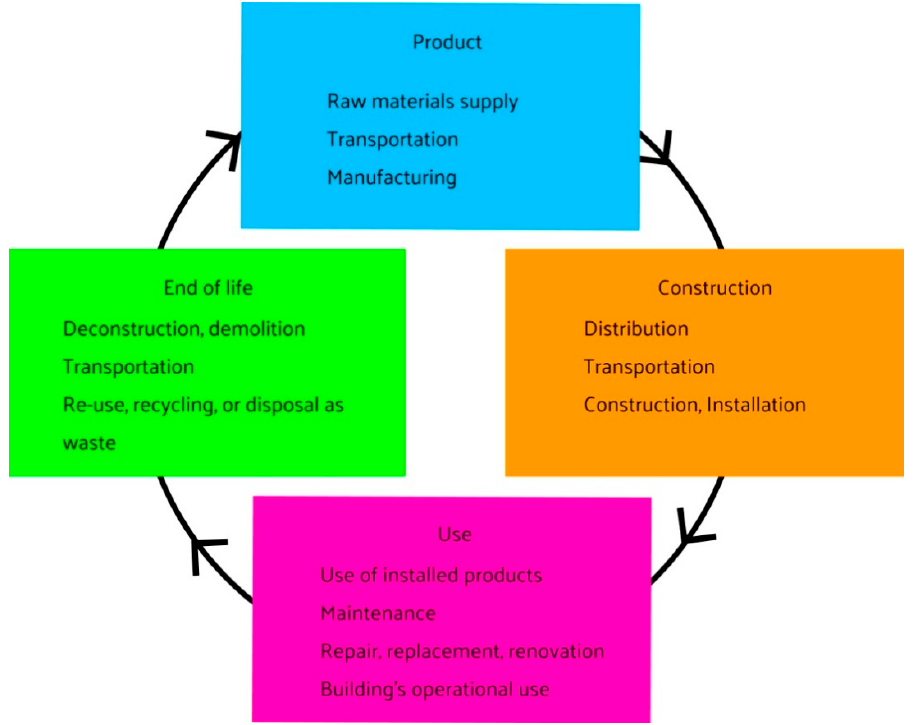
Figure 1. The life cycle of a building.